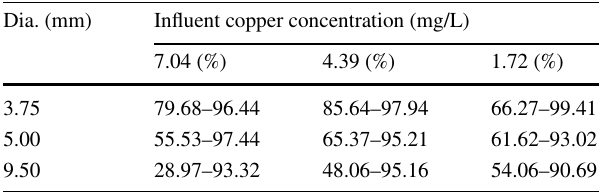
Fig. 6 The effect of volume of limestone on effluent copper concen- tration for low influent concentration of copper (1.72 mg/l) Table 6 Ranges of removal efficiency for different sizes of limestone and influent copper